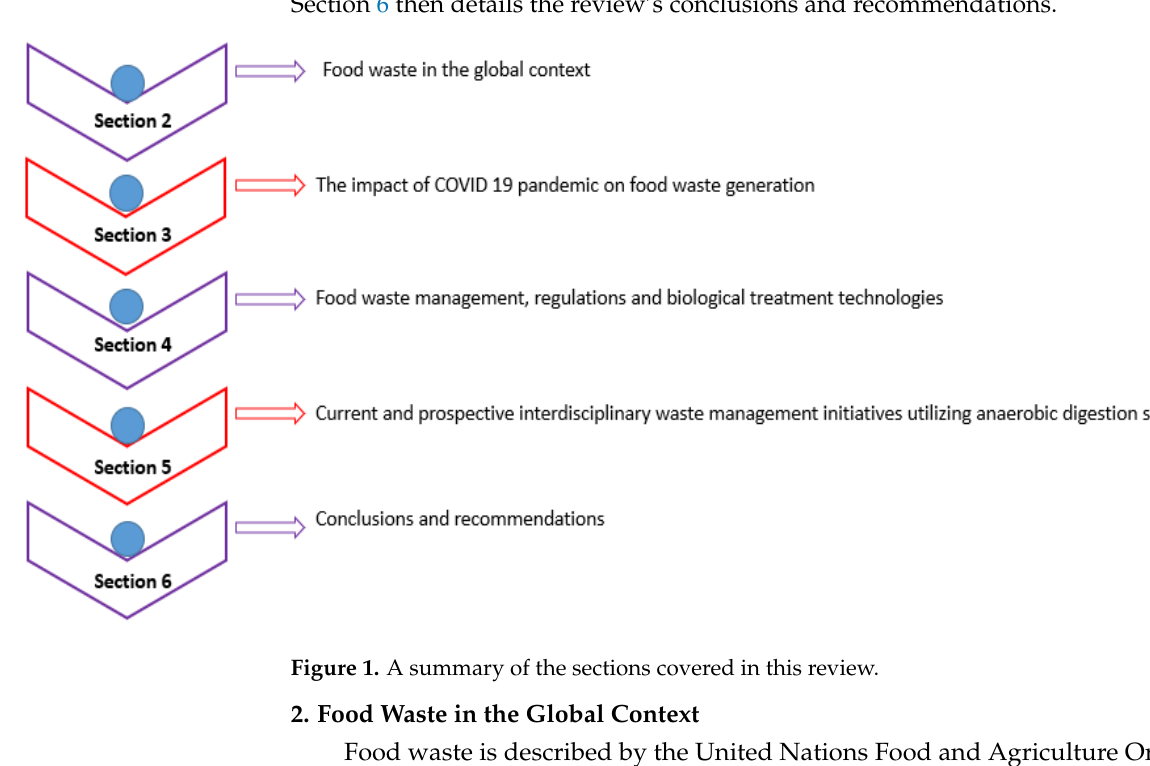
Figure 1. A summary of the sections covered in this review.